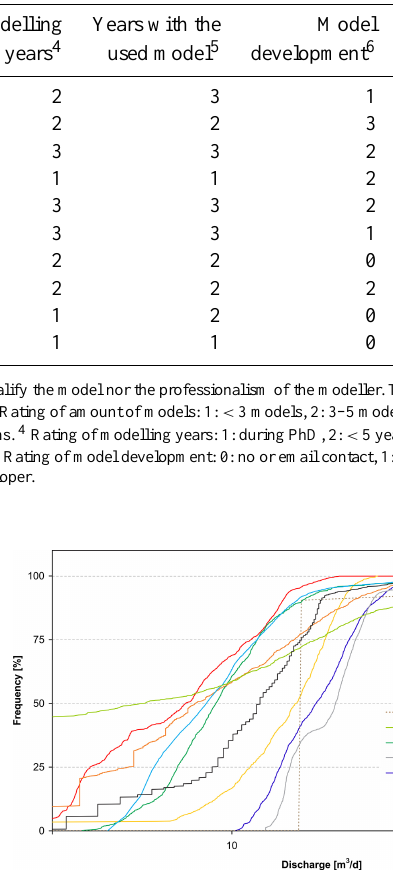
Figure 3. Discharge predicted for the hydrological year 2006/2007 (first prediction).